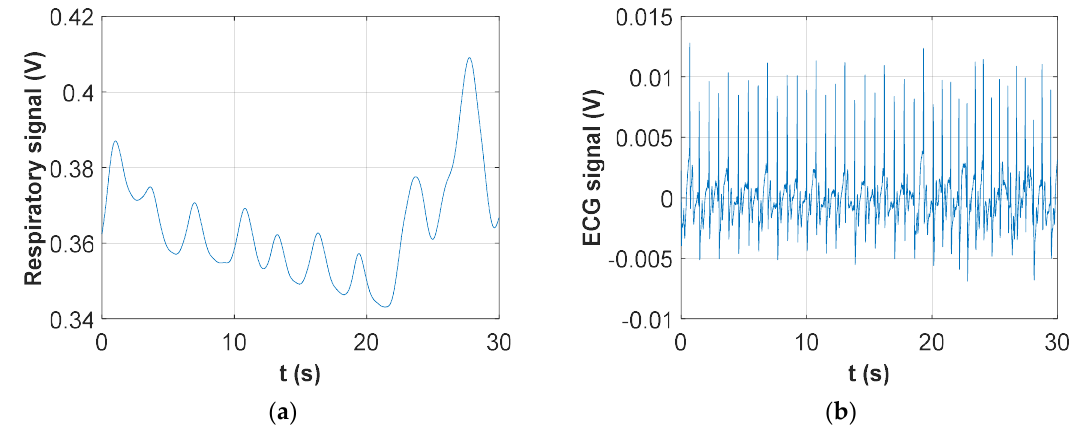
Figure 6. Signals obtained with the wireless wearable belt, after processing through the virtual